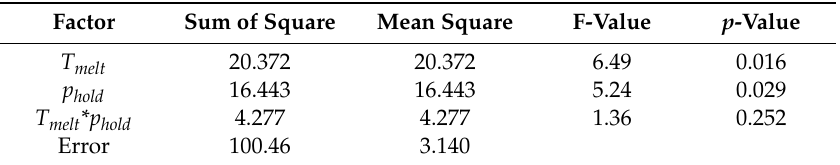
Table 3. ANOVA table for the e ff ect of the melt temperature and the holding pressure on the bonding